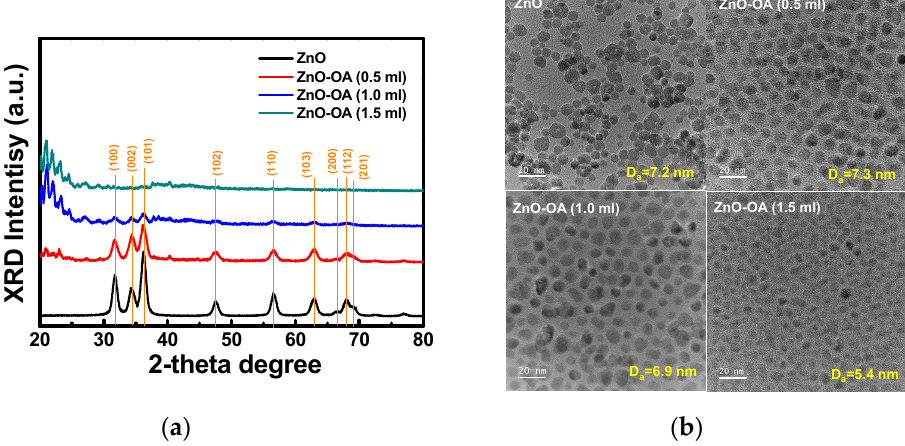
Figure 3. ( a ) XRD patterns and ( b ) HR-TEM images of ZnO QDs and ZnO-OA (0.5 mL, 1.0 mL, and 1.5 mL) QDs. 1.5 mL)